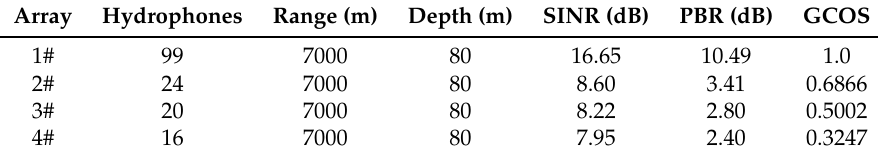
Table 1. Comparison among small and large arrays for conventional matched field processing (CMFP).